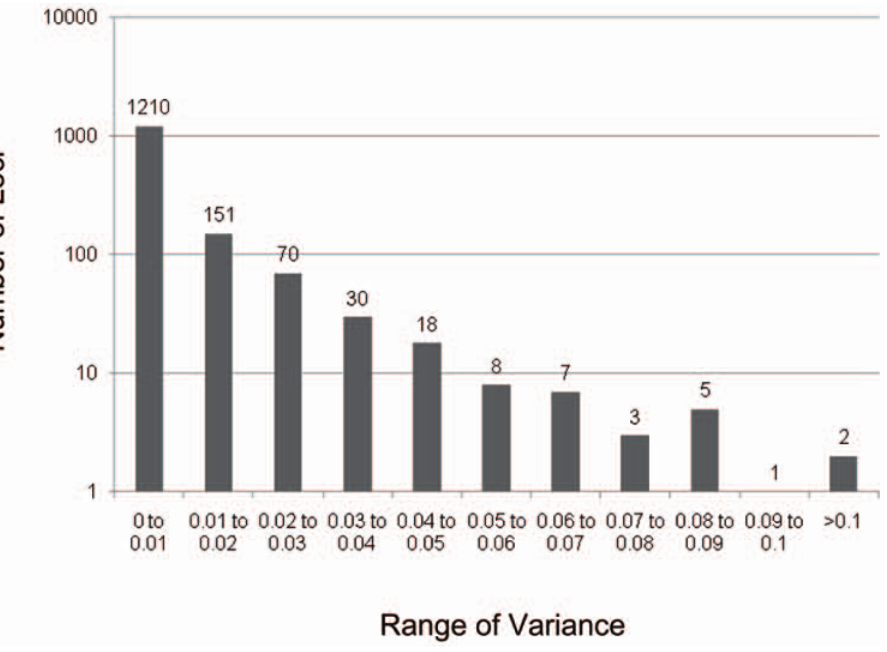
Figure 1. Frequency distribution of DNA methylation variances for 1505 CpG sites in 13 normal placental samples. The average variance is 0.007. The value for 1.5 SD above the mean variance is 0.025. There are 106 CpG sites with variance greater than 1.5 SD.